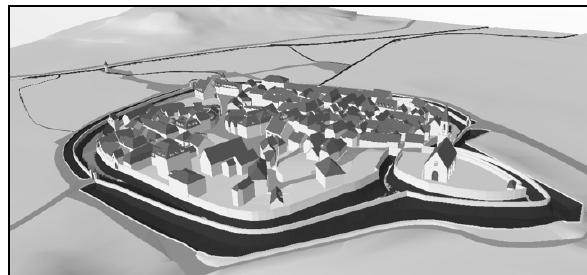
Figure 4. The VC3 model: Oblique view of Ettenheim, Germany (Source: CityGML).